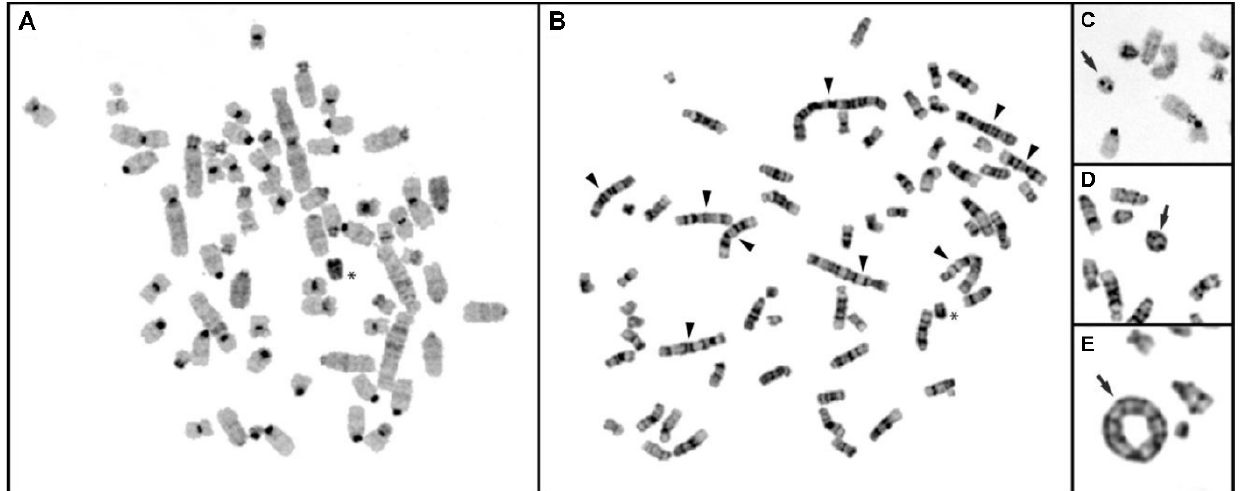
Figure 8. Conventional cytogenetic analysis of rat CFSC-2G cells. ( A ) CBG-banded metaphase spread displaying a complete heterochromatic Y chromosome (*). ( B ) GTG-banded metaphase showing numerous rearranged chromosomes (arrowheads). ( C ) CBG- as well as ( D , E ) GTG-banded partial metaphases showing ring chromosomes (arrows).